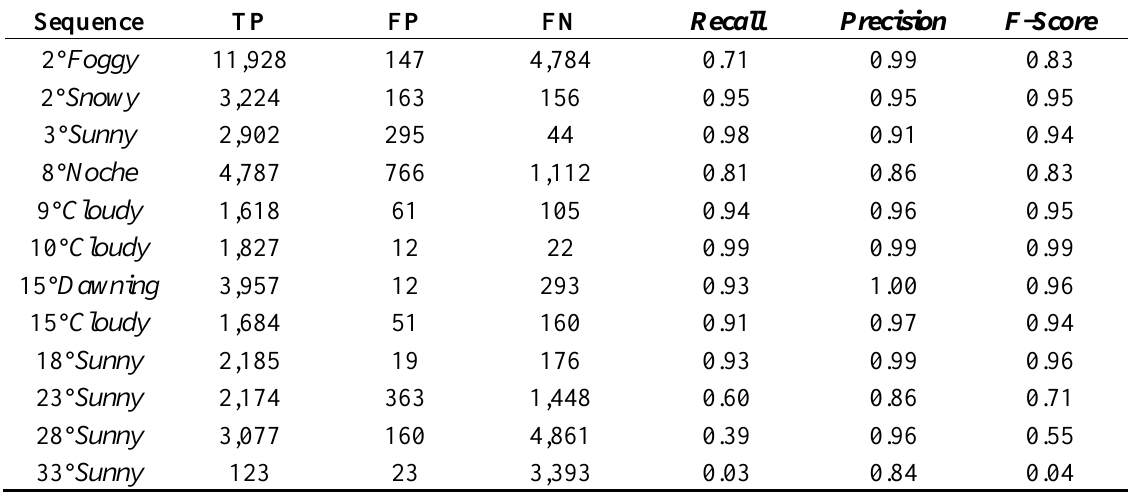
Table 1. Results of pedestrian ROI extraction in